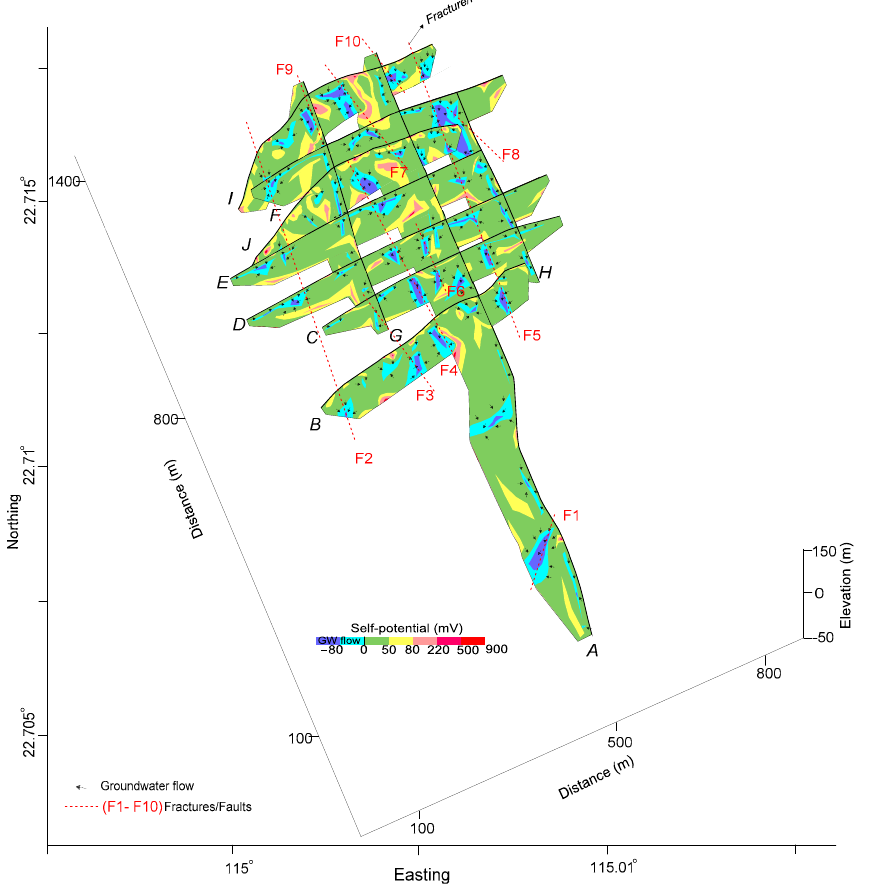
Figure 6. Integration of 2D SP models along all profiles (with SP increasing from blue to red on a color bar) interpreted for the groundwater flow modeling (shown by black arrows) and the fractures/faults (dotted reds lines).